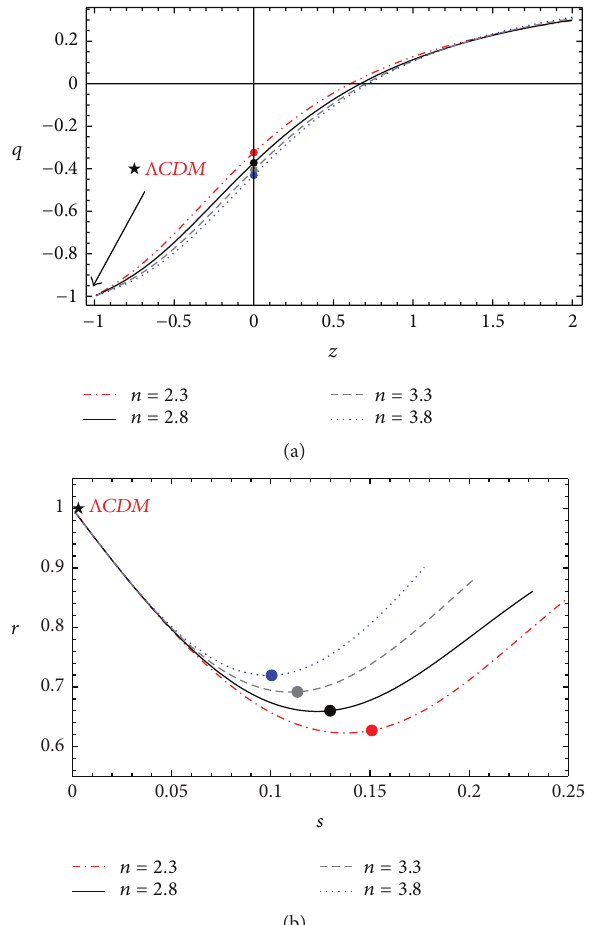
Figure 7: Evolution trajectories in NADE for (a) 𝑞 versus 𝑧 and (b) the statefinder diagnostic in 𝑠 − 𝑟 plane with −1 ≲ 𝑧 ⩽ 2 .